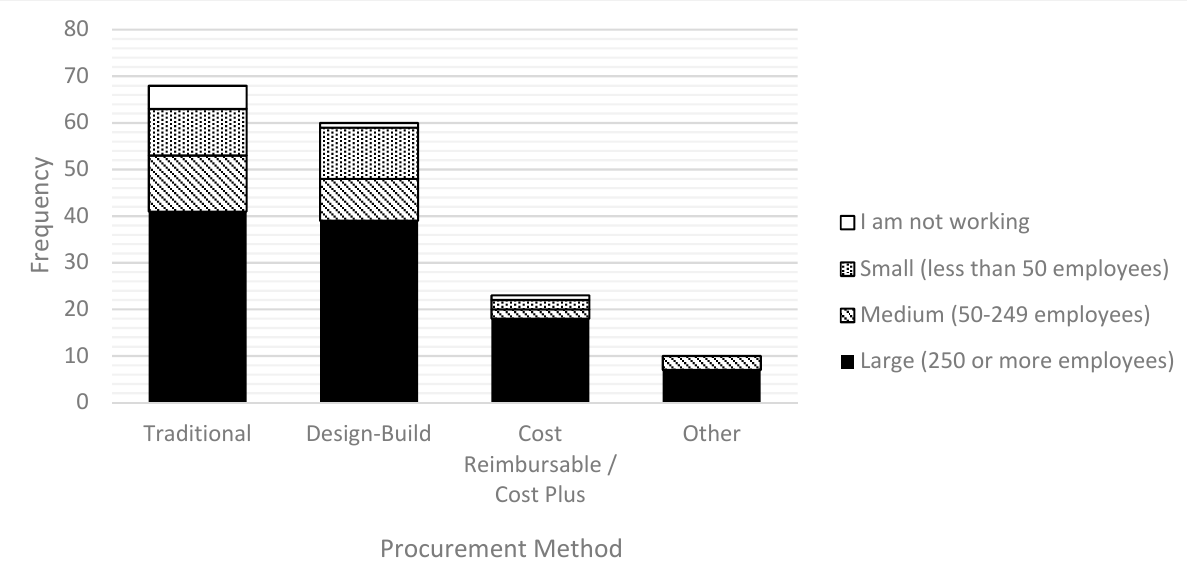
Figure 3. Procurement methods used.